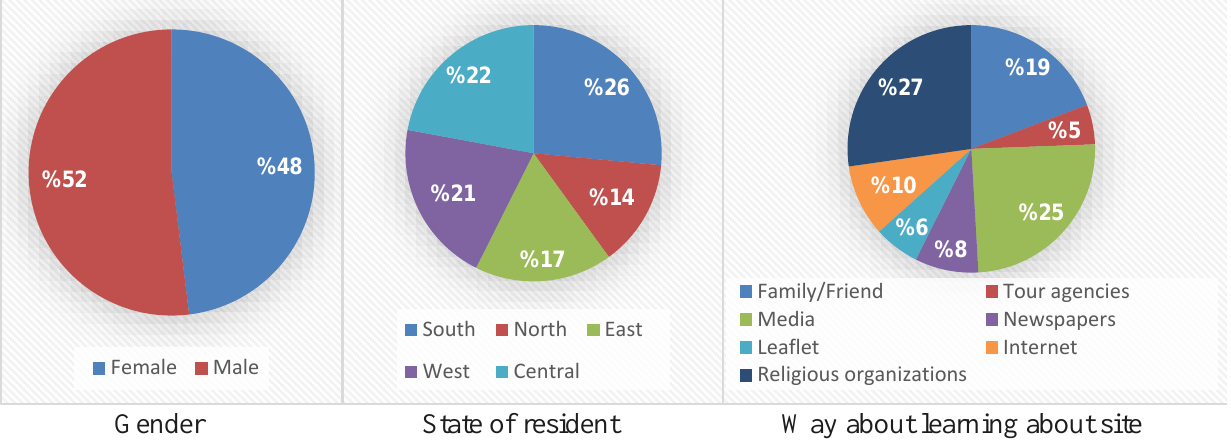
Fig. 2. Personal characteristics of the